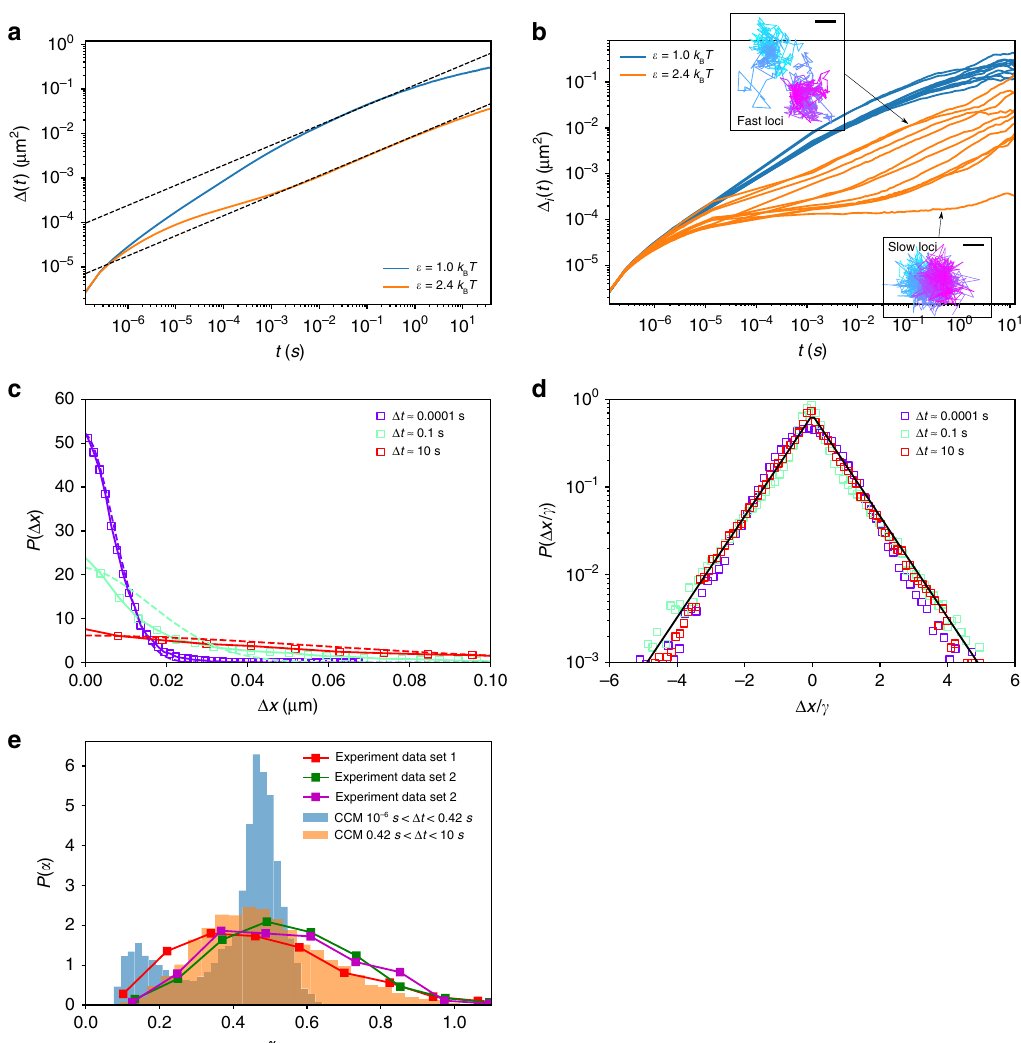
Fig. 7 Dynamic heterogeneity of individual loci. (Top) a Mean square displacement, Δ ( t ), as a function of time, t . The effective diffusion coef fi cients, D , computed from the fi tted dashed lines are 0.122 μ m 2 / t 0.45 and 0.009 μ m 2 / t 0.46 for ϵ = 1.0 k B T and ϵ = 2.4 k B T , respectively. b Time dependence of 10 single loci MSD (sMSD, Δ i ( t )) corresponding to 1st, 1000th,..., 10,000th loci for ϵ = 1.0 k B T and ϵ = 2.4 k B T . The insets show Δ i ( t ) for two trajectories for fast (top) and slow (bottom) loci. Cyan (magenta) indicates short (long) lag times. The scale bar is 35 nm (0.07 nm) for fast (slow) loci. Caging effect can be clearly observed as the plateau in Δ i ( t ) for ϵ = 2.4 k B T . c The Van Hove function P ( Δ x ) for ϵ = 2.4 k B T at lag times Δ t = (0.0001,0.1,10)s. P ( Δ x ) has heavy tail at large Δ x and cannot be fi t by a Gaussian (color dashed lines) except for Δ t = 0.0001s at small Δ x . d Same as c except displacement Δ x is normalized by its standard deviation γ . P ( Δ x / γ ) for different lag times collapse onto a master curve. The black line is an exponential fi t, ~ e − η ( Δ x / γ ) with η ≈ 1.3. e Distribution, P ( α ), of the effective diffusion exponent α . Comparison to experimental data 54 are shown. The values of α are extracted from single loci trajectories by fi tting sMSD, Δ i ( t ) ~ t α . The lag time range 0.42 s < Δ t < 10 s is in the approximate same range probed in the experiment. Experimental data set 1, 2, 3 are from Fig. 2b, c, and S5 of ref. 54 , respectively. The results from our simulation (orange) agree well with experimental data, shown as orange. The blue bar plot is P ( α ) for small lag times 10 − 6 s < Δ t < 0.42 s. It shows two peaks, indicating the coexistence of two populations of loci with